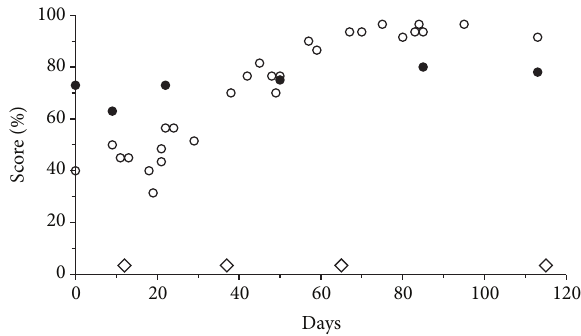
Figure 3: Sequential MBT ( l ) and ETDRS ( ∙ ) results from a patient with newly diagnosed wet AMD in the right eye. The intervals between clinical ETDRS examinations define epochs within which trends of MBT results were assessed. Diamonds ( ⬦ ) identify times of